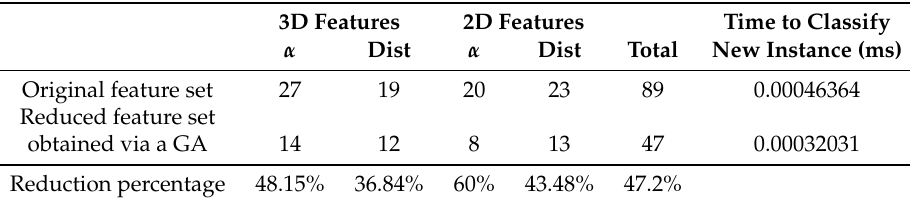
Table 17. Comparison between the original and reduced feature sets.